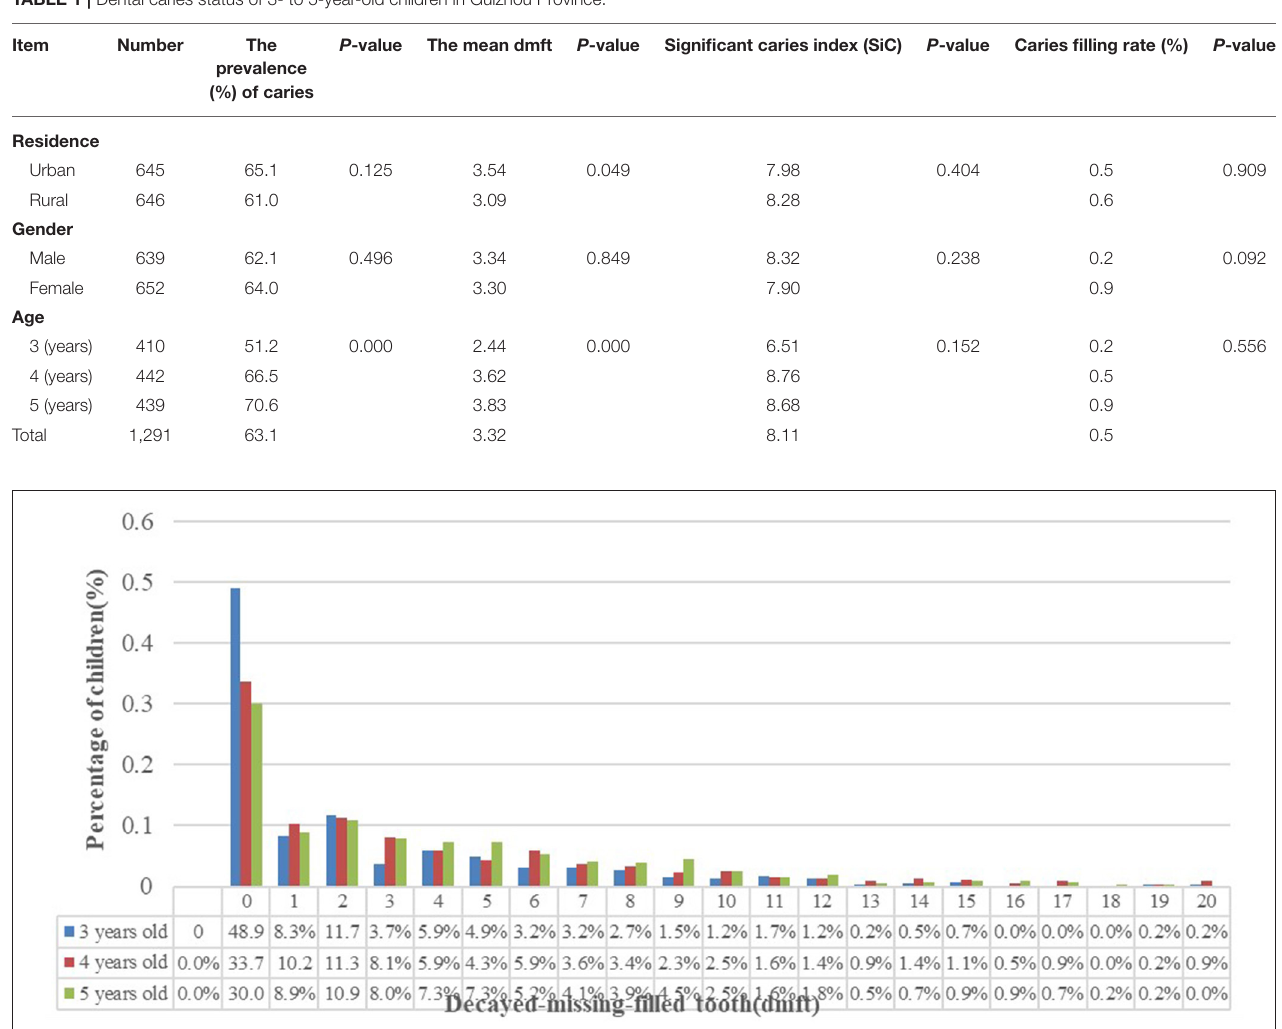
FIGURE 1 | Distribution of the mean decayed-missing-filled teeth (dmft) frequency in deciduous teeth in children aged 3–5 years in Guizhou Province.